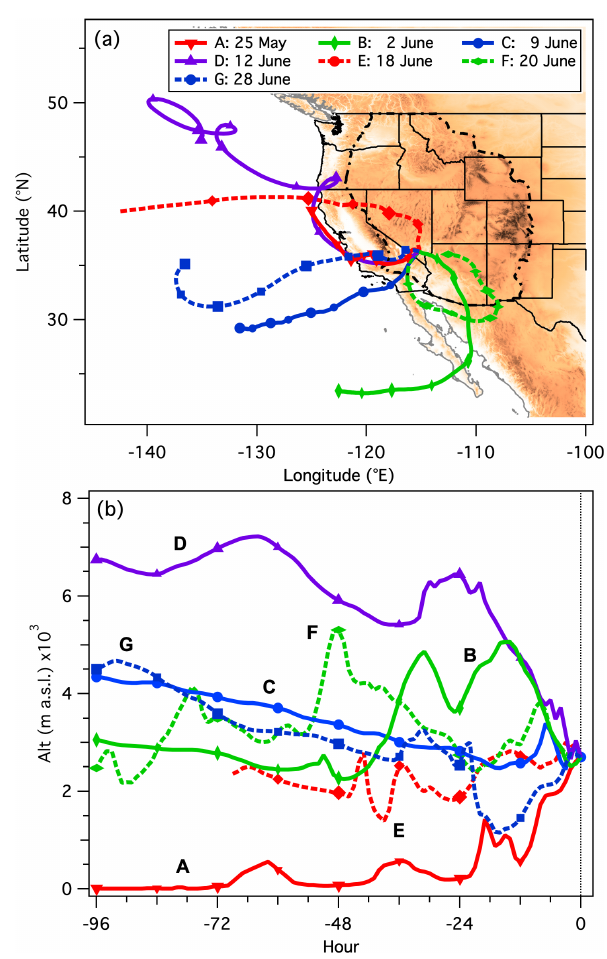
Figure 18. NOAA HYSPLIT 96h back trajectories launched 2km above North Las Vegas during episodes A–G. The small and large filled symbols are spaced 12 and 24h apart, respectively. The trajec- tories were calculated using the 40km NCEP Eta Data Assimilation System (EDAS)